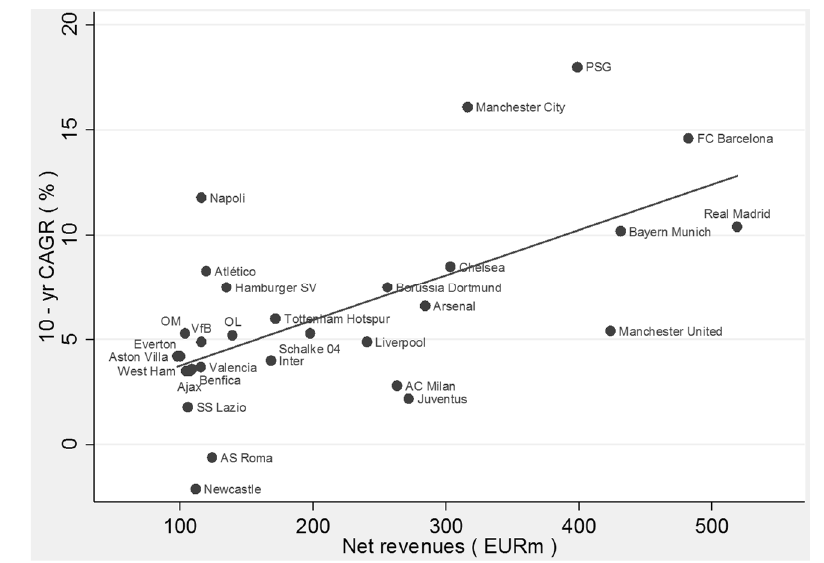
Figure 1. Revenues in 2013 vs. 10-year growth rates of top 30 EU football clubs. Sources: Deloitte Football Money League; Club financial accounts.